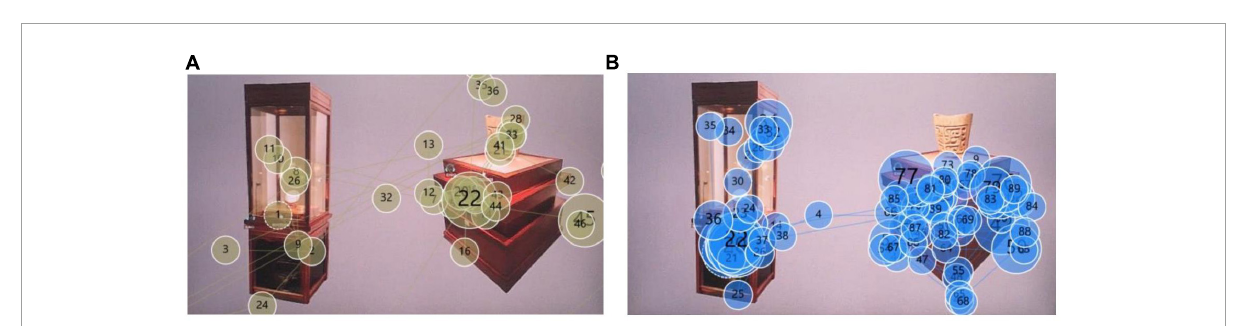
FIGURE10 Total heat map of subject’s fixation.